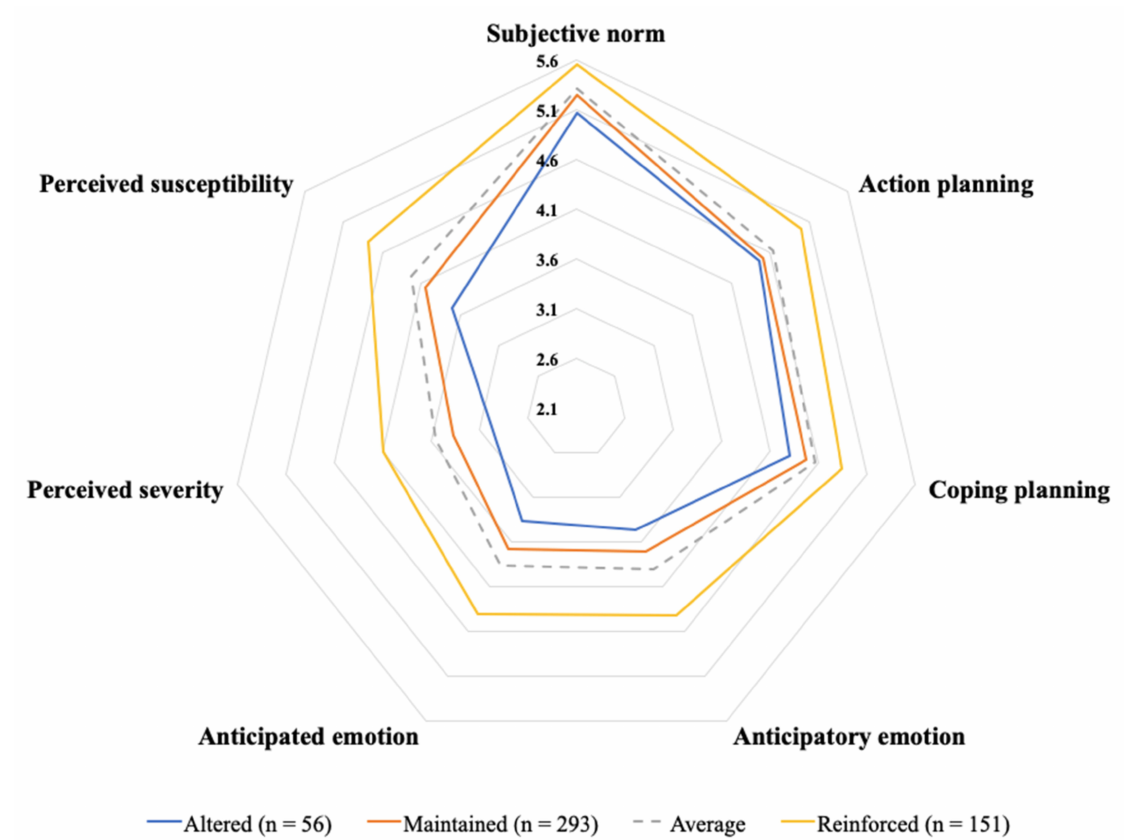
Figure 1. Descriptive statistics (altered, maintained and reinforced).